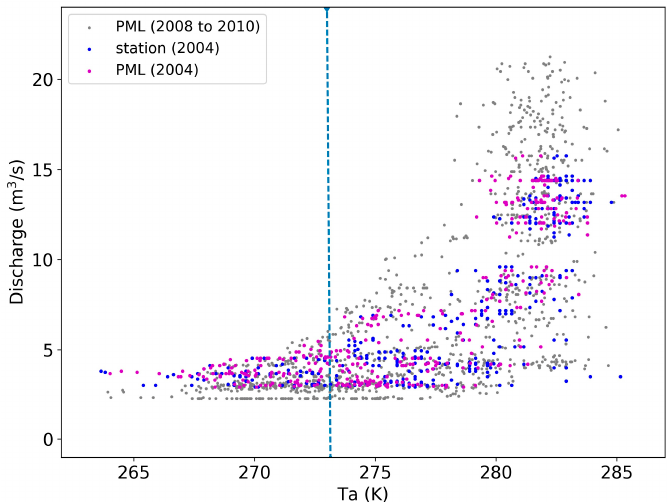
Figure 11. Relationship between daily Ta at the Kyanging station and daily discharge measured at the watershed outlet (blue points represent the station observed Ta and discharge in 2004; magenta points are the PML based Ta and discharge in 2004; dark points are the PML based Ta and discharge during 2008–2010; and the vertical dashed line at 273.15 K indicates the freezing point).